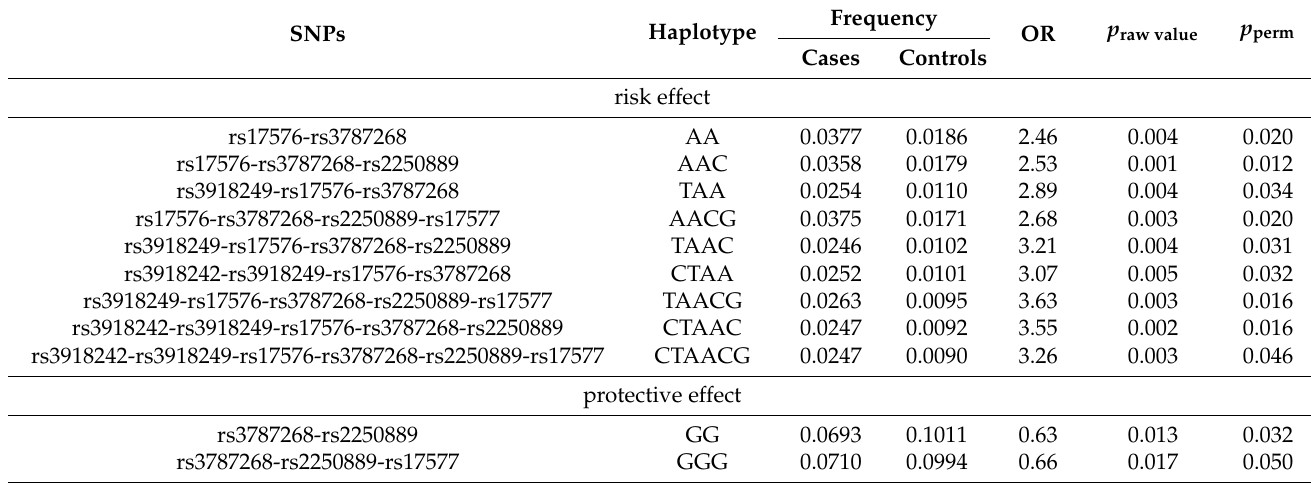
Table 3. Significance associations of the MMP-9 gene haplotypes with breast cancer risk. SNPs Haplotype